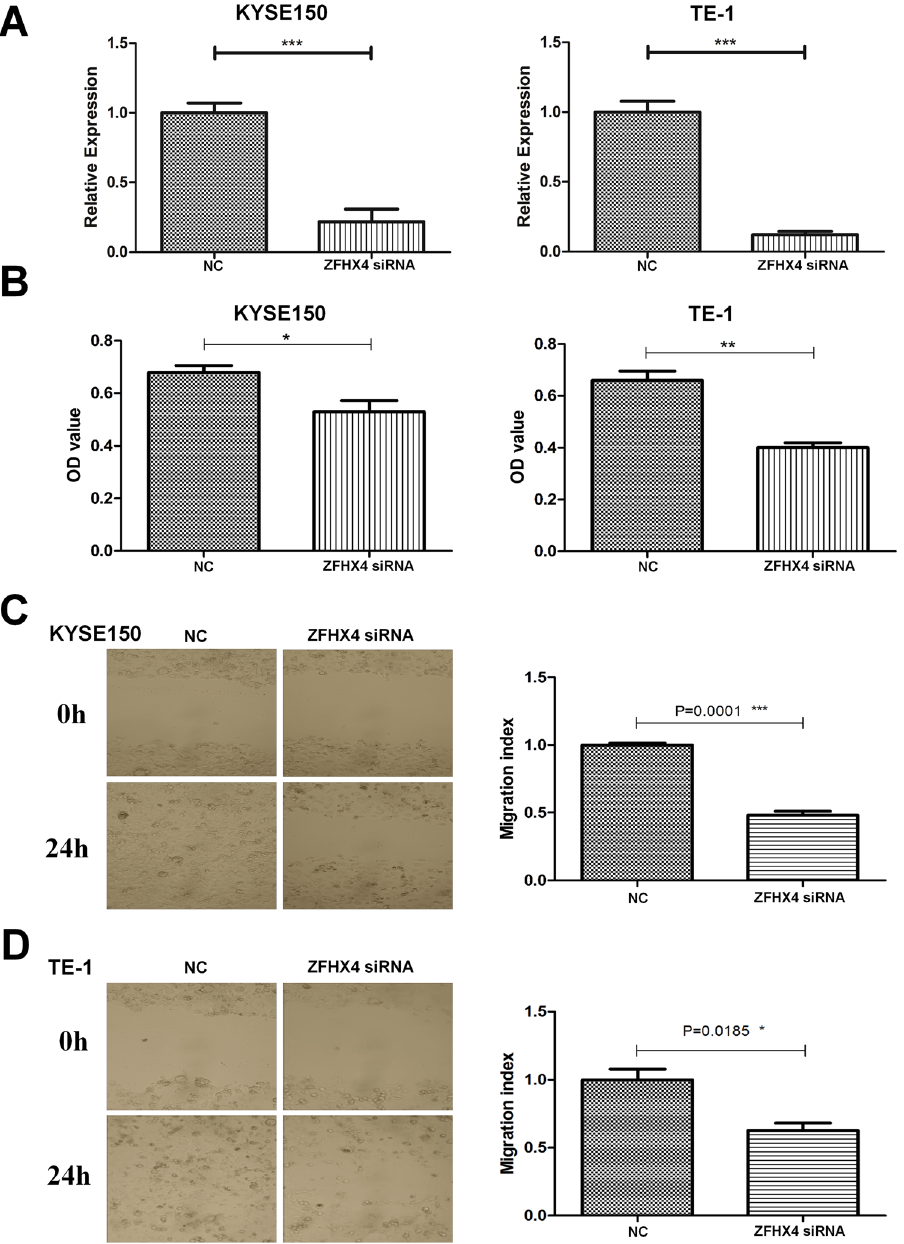
Figure 5. Validation of the biological functions of ZFHX4 with RNA interference. Data and images were shown for two cell lines: KYSE150 and TE-1. ( A ) After 48 h, ZFHX4 expression was evaluated by real-time RT–PCR in control (NC) and siRNA of ZFHX4. ( B ) In vitro invasion activity of KYSE150 and TE-1 cells after treatments with siRNA of ZFHX4 . ( C , D ) The images showed distance migrated by the cell monolayer to close the wounded area at starting point and after 24 h of ZFHX4 knockdown in KYSE150 and TE-1 cell lines. Bars represent the motility index of each treatment, and all data represented the mean ± s.d. of three replicates. The p values were calculated using the Student’s paired t-test, two-tailed. * p < 0.05; ** p <